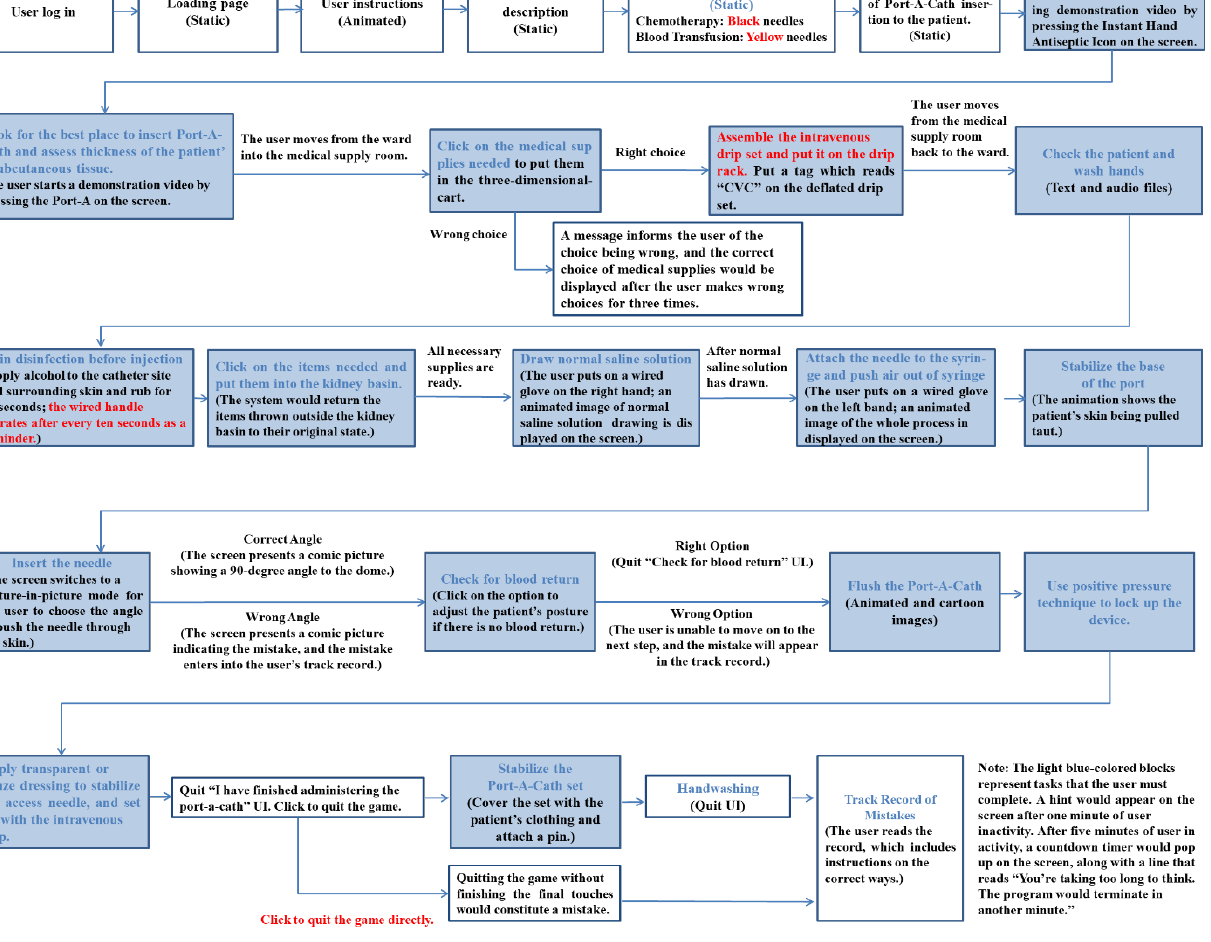
Figure 1. Procedure of a virtual reality implanted Port-A catheter. Note: Red color characters provide a hint for the user. Light blue background indicates main steps.